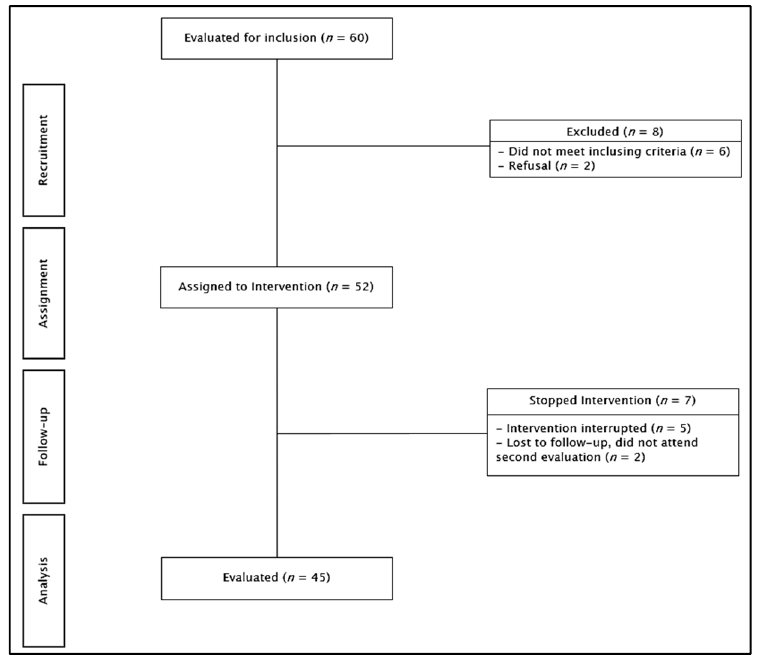
Figure 1. Participant flowchart.